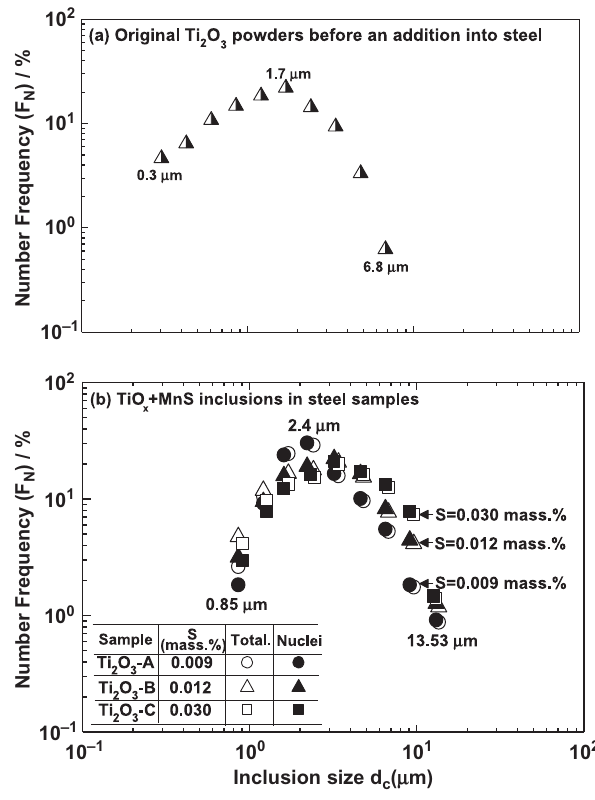
Figure 5: Size distribution of (a) original Ti 2 O 3 powders and (b) TiO x + MnS inclusions in steels with Ti 2 O 3 additions [15,